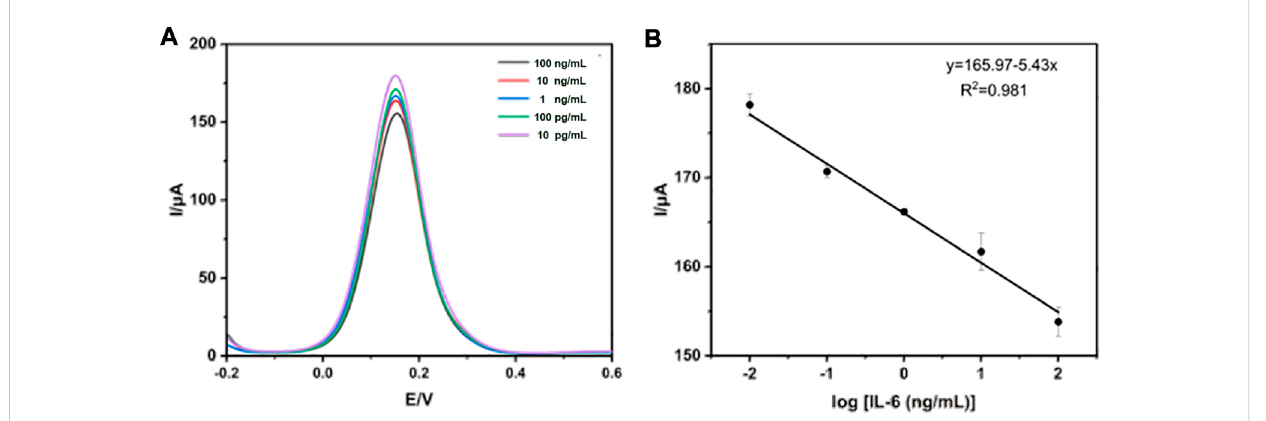
FIGURE 5 Detection of standard IL-6 using DPV technology. (A) The measurement of standard IL-6 ranged from 10 – 2 – 10 2 ng/mL (B) The calibration curve of the electrochemical immunosensor.